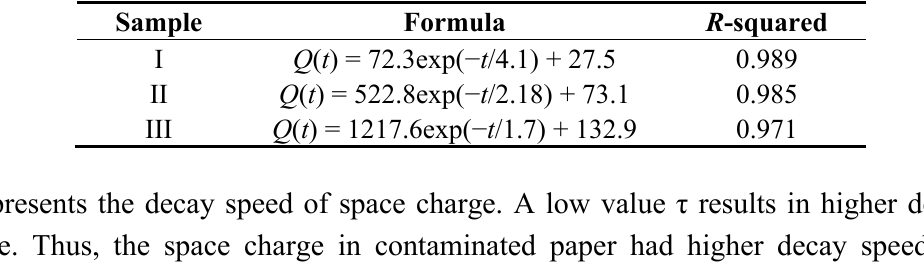
Table 4. Relationship between space charge amount and time for oil impregnated